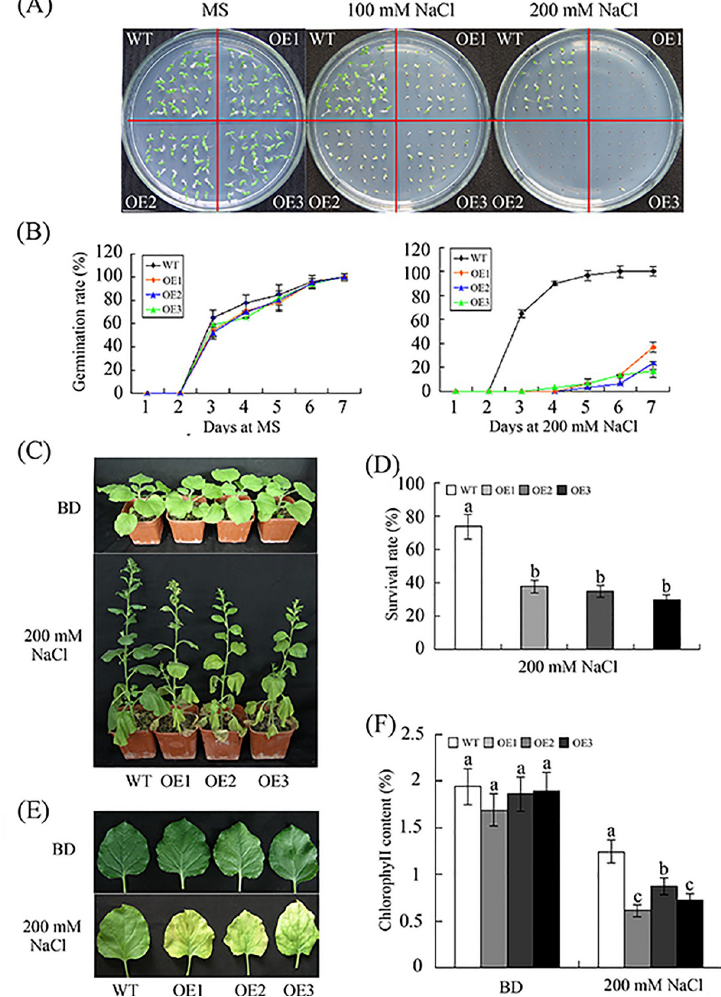
Fig 6. Reduced salt tolerance in transgenic plants overexpressing GhWRKY68 . (A) Seed germination on 1/2 MS medium containing different concentrations of NaCl. (B) Germination rates of the WT and OE lines under 0 or 200 mM NaCl treatment conditions. Germination was scored daily. (C) Representative phenotypes of 8-week-old WT and OE plants grown in soil before and after 200 mM NaCl treatment for 1 month. (D) Survival rates of WT and OE plants after 200 mM NaCl treatment. (E) Representative phenotypes of the detached leaves of WT and OE plants treated with 200 mM NaCl. (F) Quantification of chlorophyll content. The values represent the chlorophyll content in the salt- treated plants relative to that of the untreated plants. BD, before drought treatment. The data presented are the means ± SE of three independent experiments (n = 3). Different letters above the columns in (D) and (F) indicate significant differences (P < 0.05) according to Duncan’s multiple range test performed using SAS version 9.1